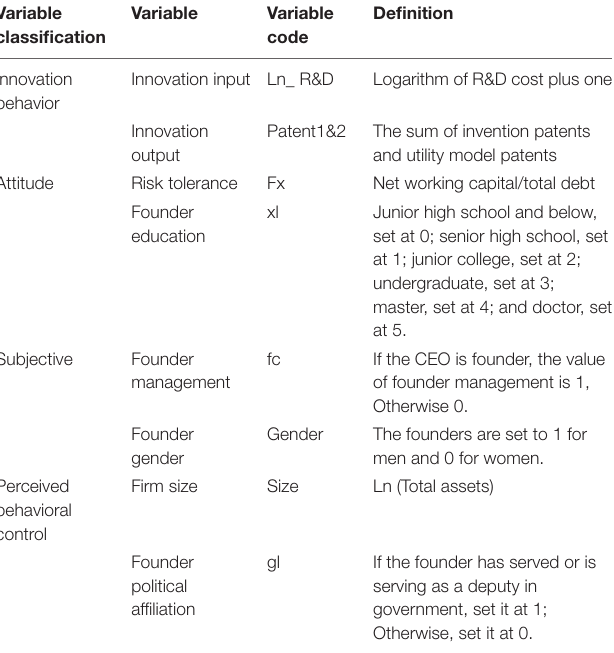
TABLE 1 | Variable design.